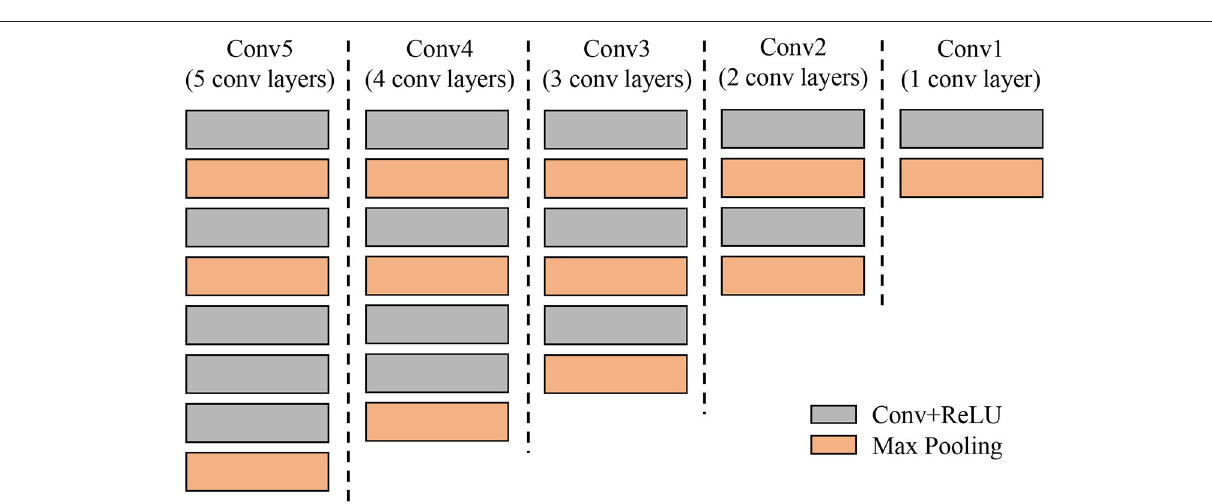
Frontiers in Plant Science |